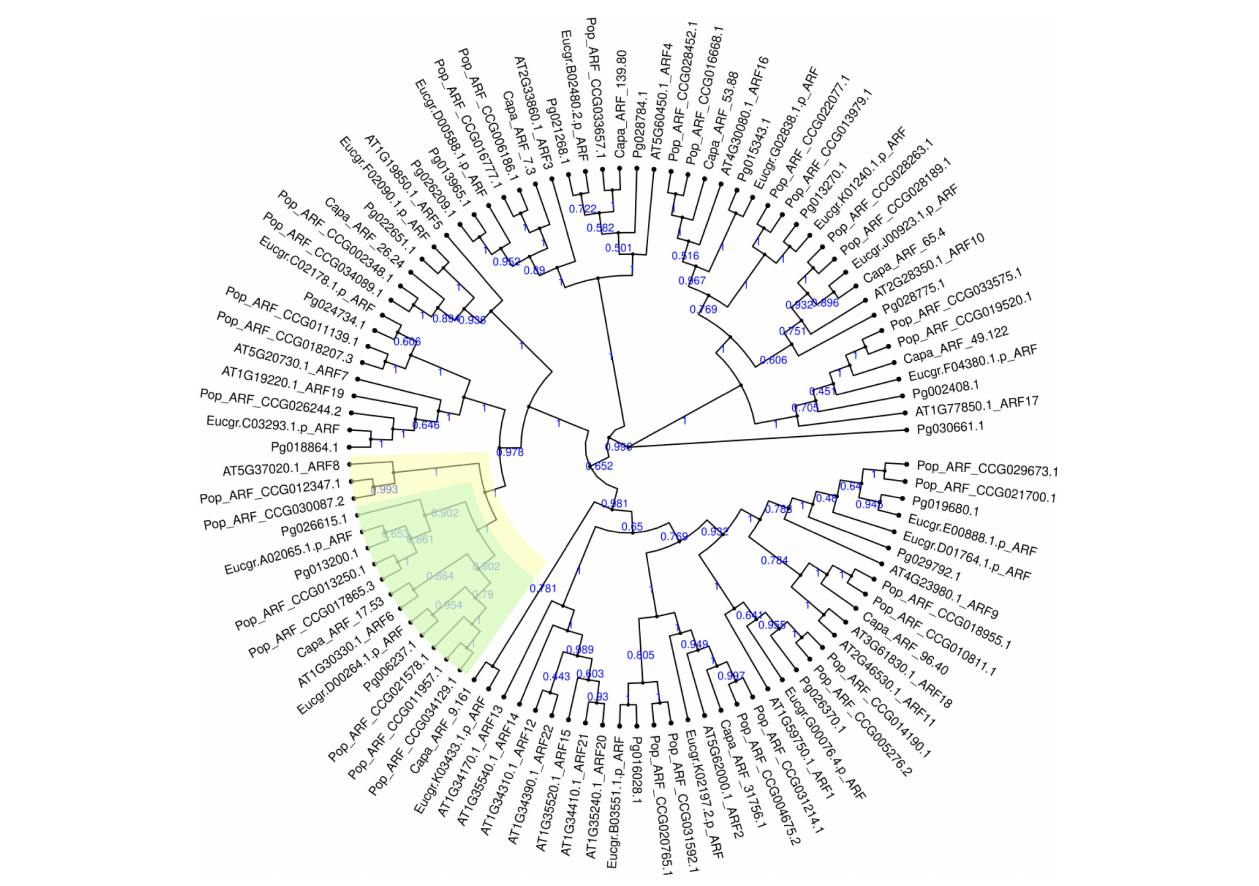
FIGURE 1 | Phylogenetic tree of ARF gene family in Punica granatum (Pg), Eucalyptus grandis (Eucgr), Populus euphratica (Pop), Carica papaya (Capa), and Arabidopsis thaliana